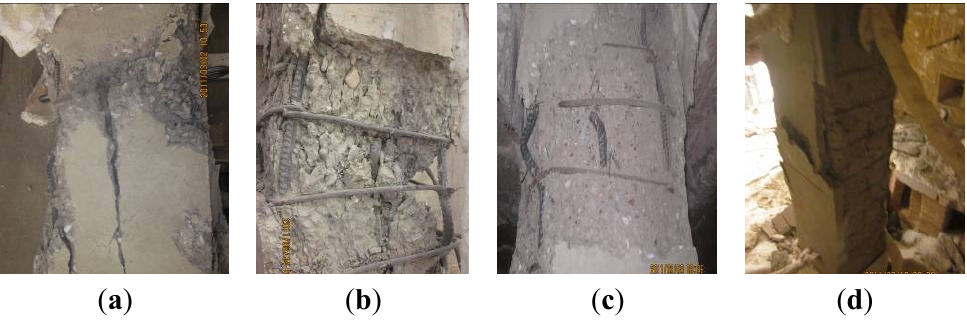
Figure 12. Local failure modes of specimens: ( a ) upper 1/3 of NCC-1; ( b ) lower part of NCC-2; ( c ) upper 1/3 of RCC-1; and ( d ) lower part of